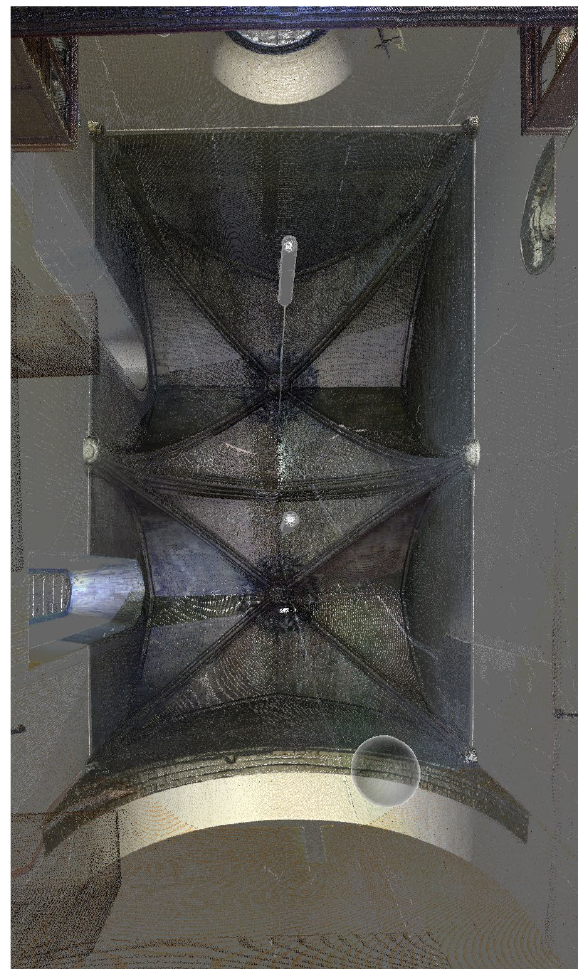
Figure 4 . The vaults covering the navi of the Chapel of San